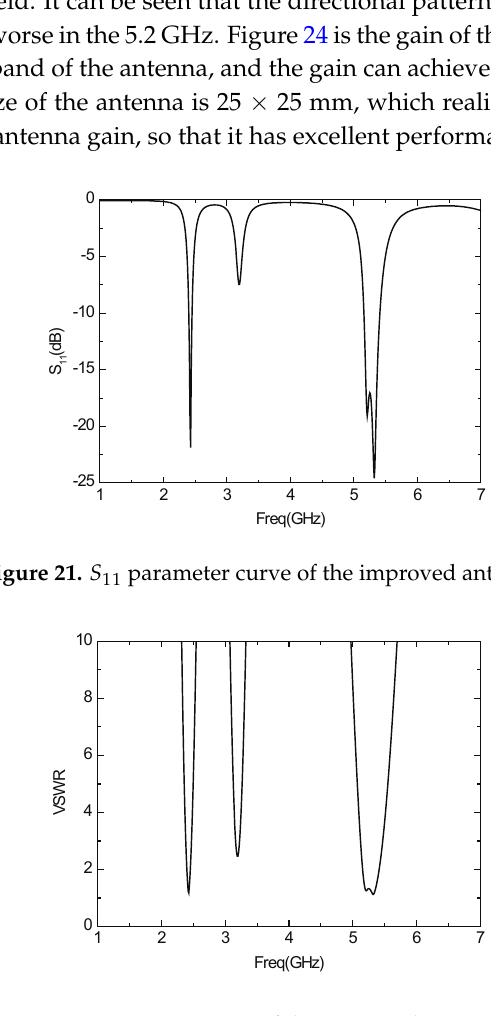
Figure 22. VSWR curve of the improved antenna.